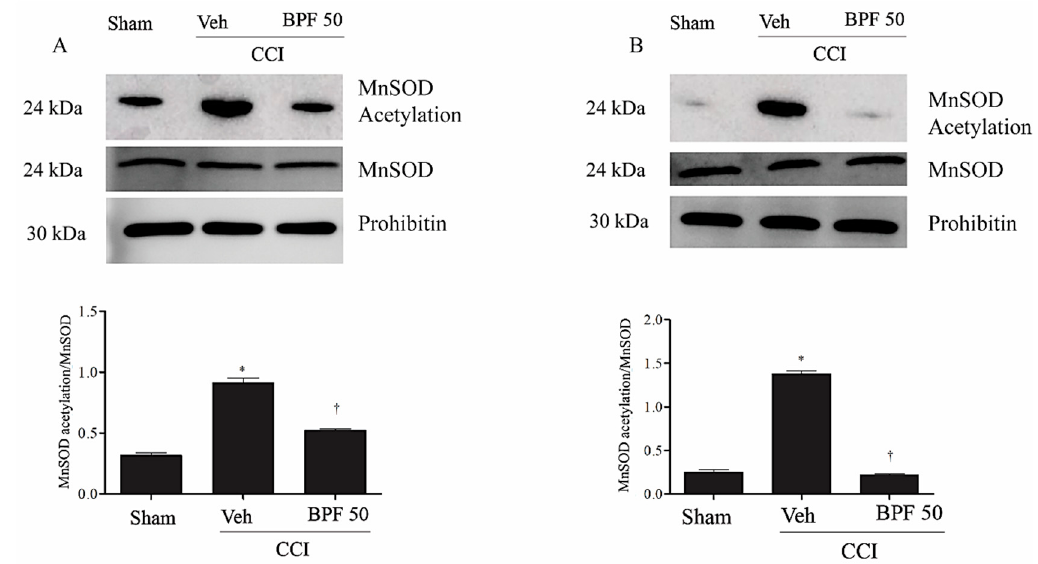
Figure 10. The inhibition of SIRT3 led to MnSOD acetylation. Inactivation of mitochondrial SIRT3 by the CCI injury induced mitochondrial MnSOD acetylation either 14 days ( A ) and 21 days ( B ) post injury as measured by immunoprecipitation. Subcutaneous infusion of BPF (50 mg/kg), concurrently with surgery (day 0), prevented MnSOD acetylation. In these conditions, prohibitin or MnSOD expression was statistically the same among the lanes. Gels are representative of results from 6 animals. Densitometric analyses of all animals per groups are reported MnSOD and acetylated MnSOD were first normalized with prohibitin and then these values were used to obtain acetylated/total MnSOD ratio. Results are expressed as mean ± SEM for 6 rats. * p < 0.05 versus sham; † p < 0.05 versus vehicle + CCI.